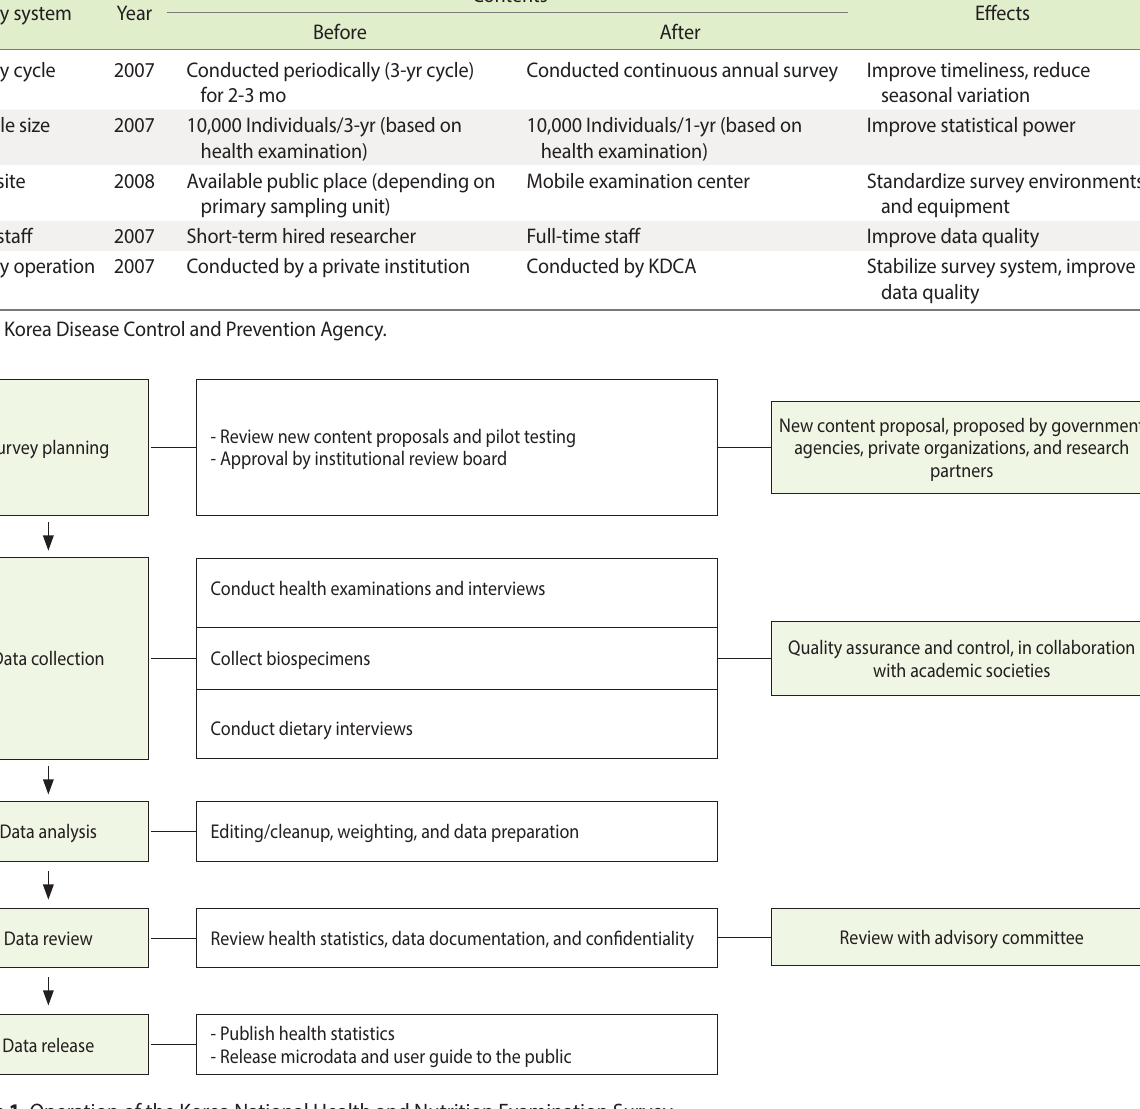
Figure 1. Operation of the Korea National Health and Nutrition Examination